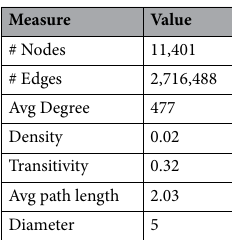
Table 1. Summary statistics of the web graph